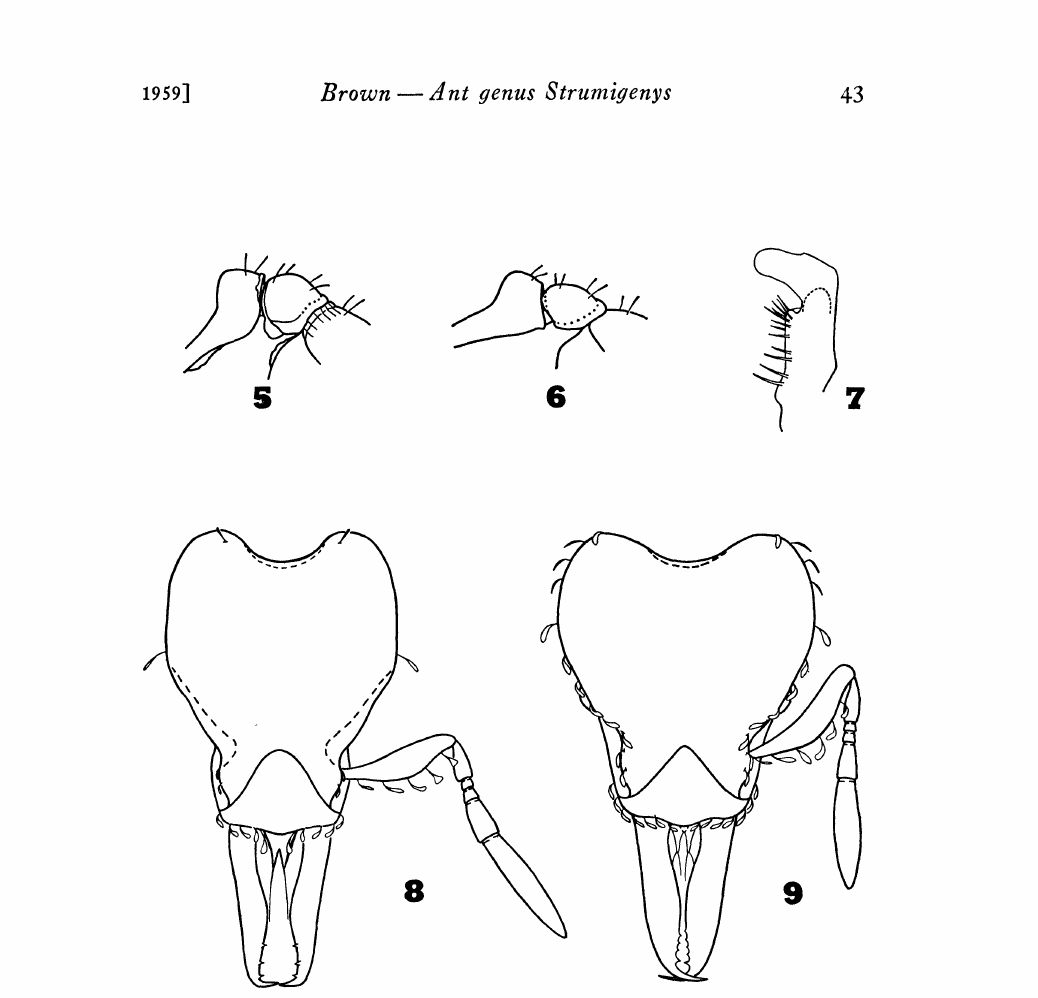
Figures 5-9. Strumigenys of the gundlachi group. Figure 5, S. gundlachi side view o pedicel to show spongiorm appendages; same specimen as Figure 1. Figure 6, S. eggersi, side view o pedicel, same specimen as Figure 2. Figure 7, ,7. subedentata male, volsella of genitalia, Mixeo, Guatemala. Figure 8, Strumigenys trieces, new species, holotype worker. Figure 9, ,7. subedentata, worker from Panama Canal Zone. Figures 5, 6, 8 and 9 are drawn to the same scale as Figures 1-4; Figures 8 and 9 carry the same conditions as